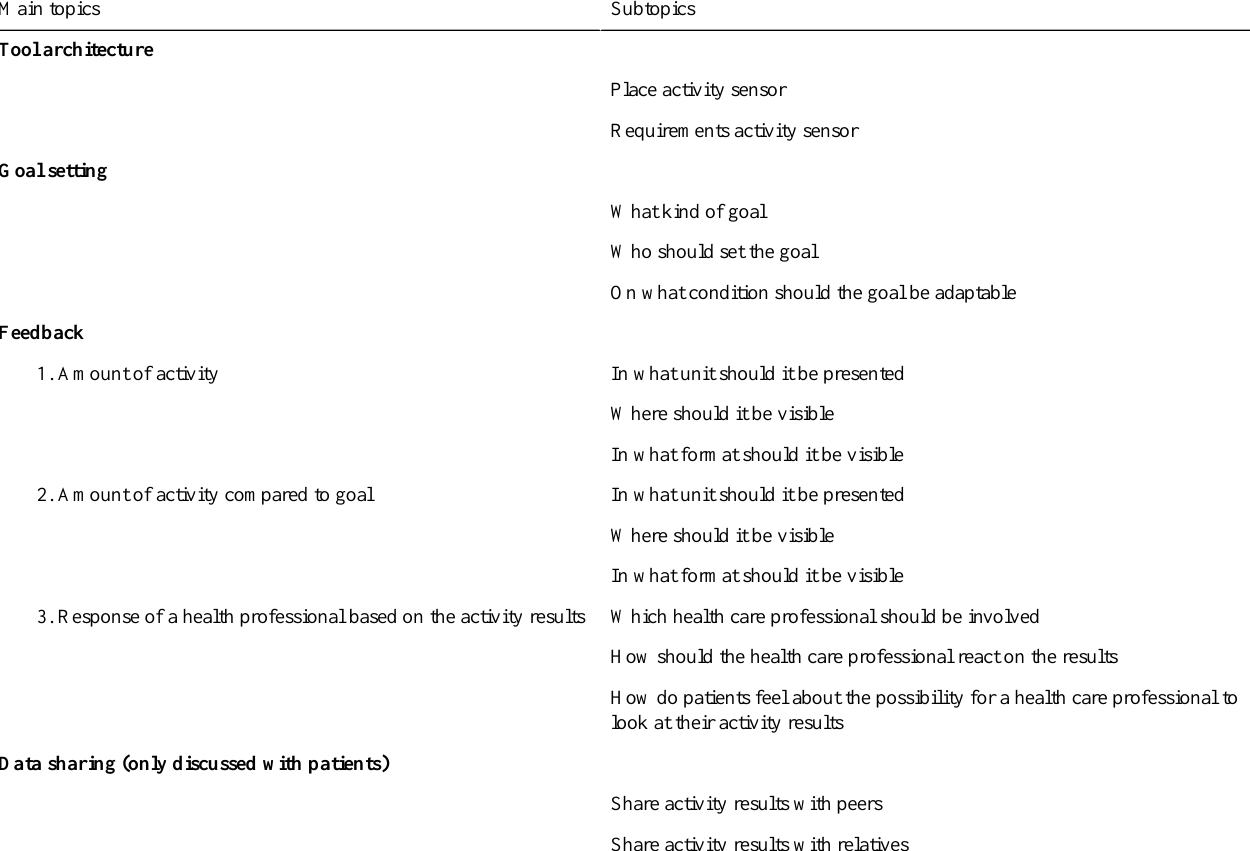
Table 1. Interview topics regarding the tool for patients and